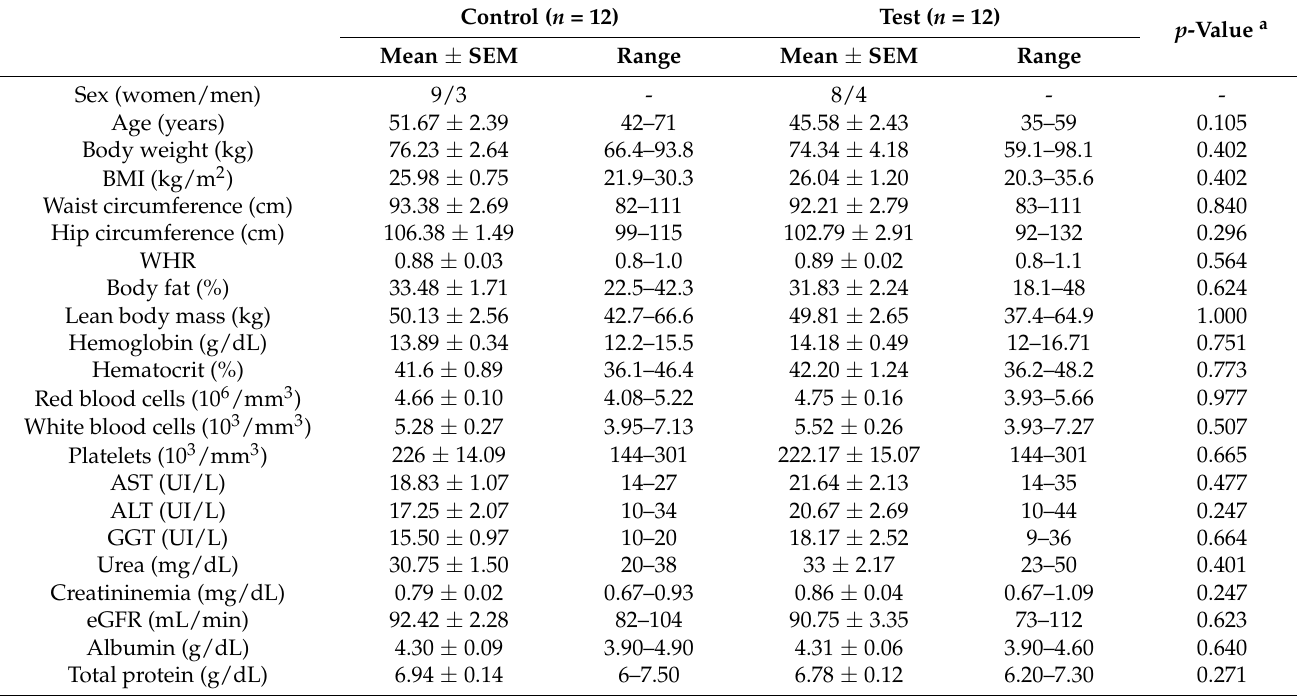
Figure 1. Recruitment flow diagram. Table 2. Baseline characteristics of participants in control and test